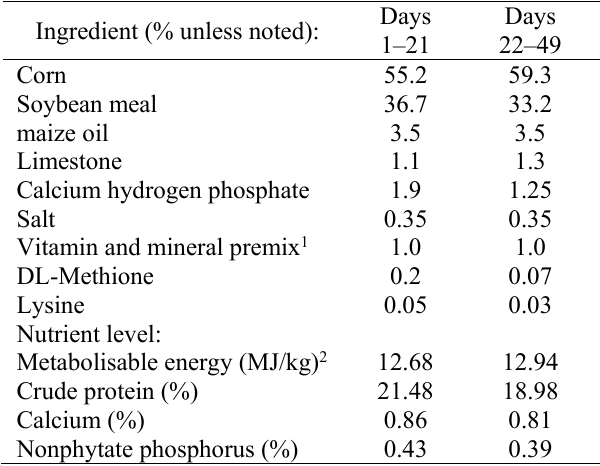
Composition and nutrition levels of the basal diets (Dry material